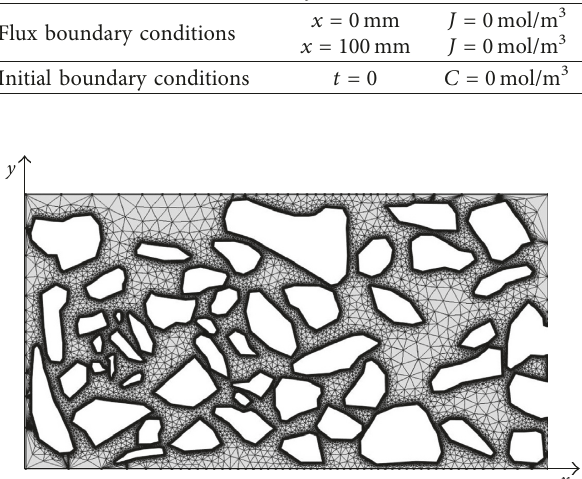
Figure 7: Element mesh of the concrete numerical